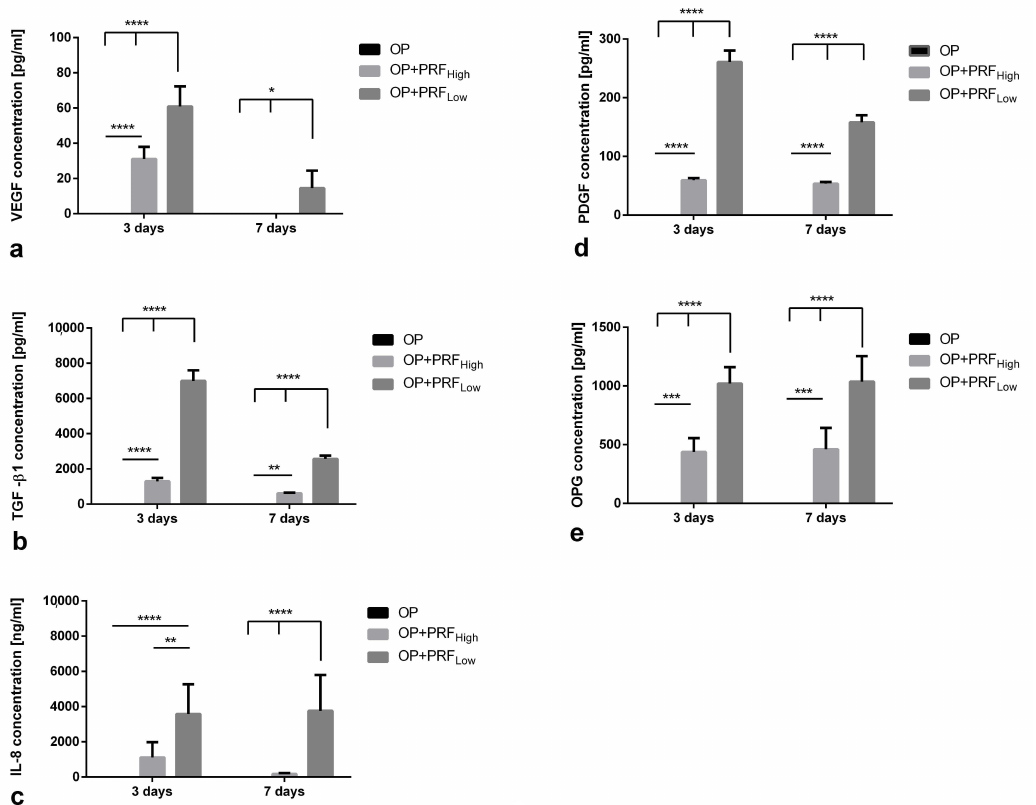
Figure 2. Evaluation of concentration of different growth factors and cytokines released in culture supernatants of low and high PRF coated materials (OP+PRF High and OP+PRF Low ) without primary Osteoblasts. p -value < 0.05 *, p -value < 0.01 **, p -value < 0.001 *** or p -value < 0.0001